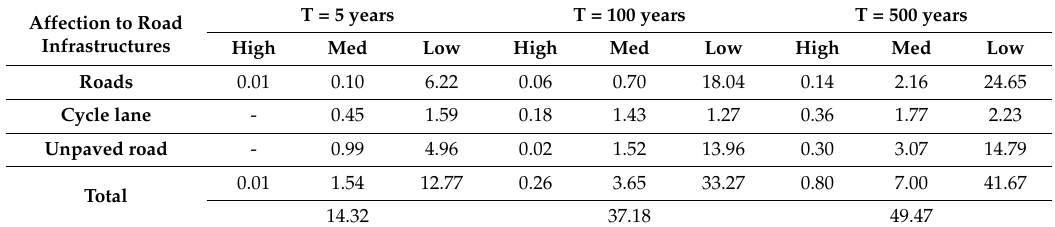
Table 6. Impact of floods (km) on different types of urban roads in each scenario.